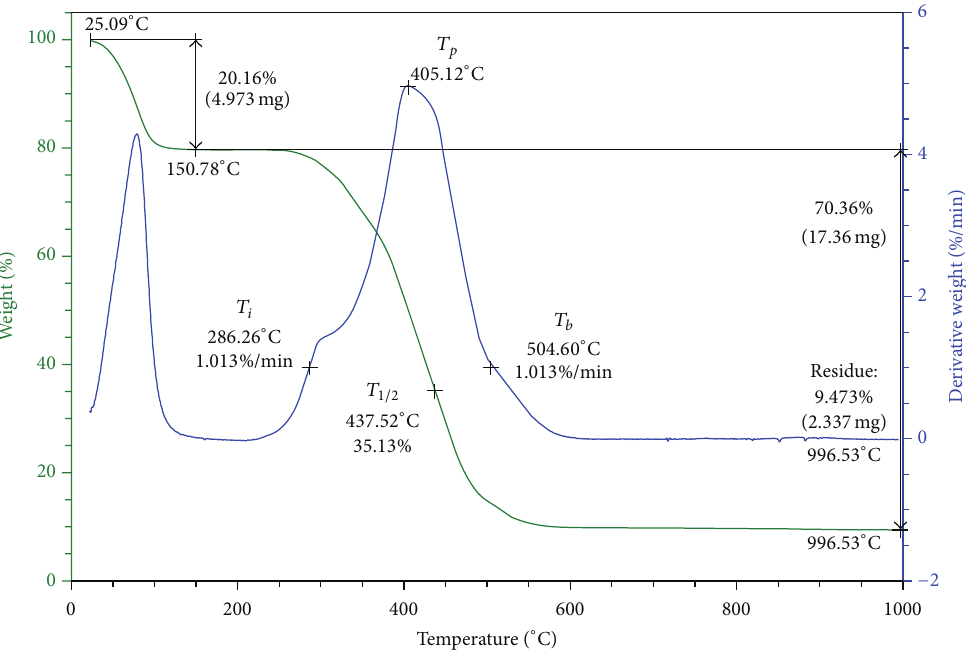
Figure 5: TGA/DSC combustion thermogram for Odagbo coal.